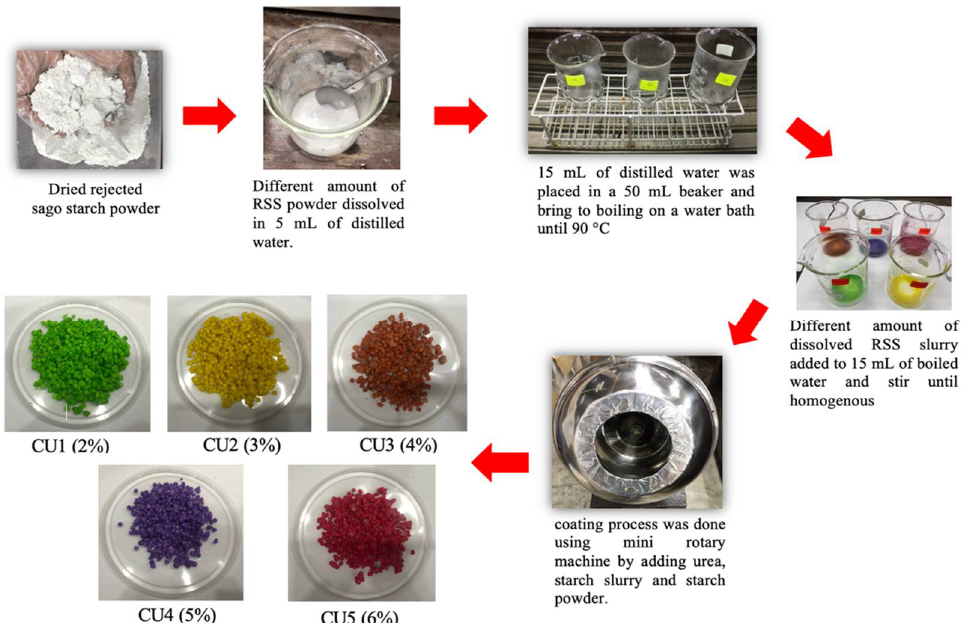
Figure 3. Procedures of urea coating with different concentrations of rejected sago starch.